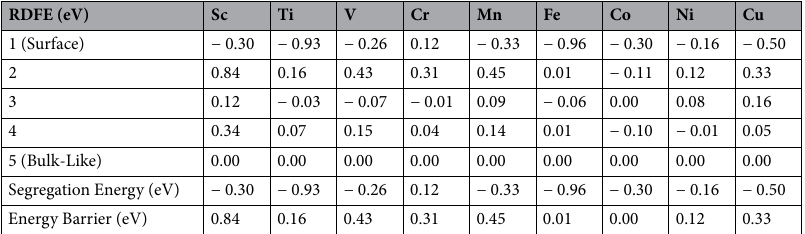
RDFE (eV) Sc Ti V